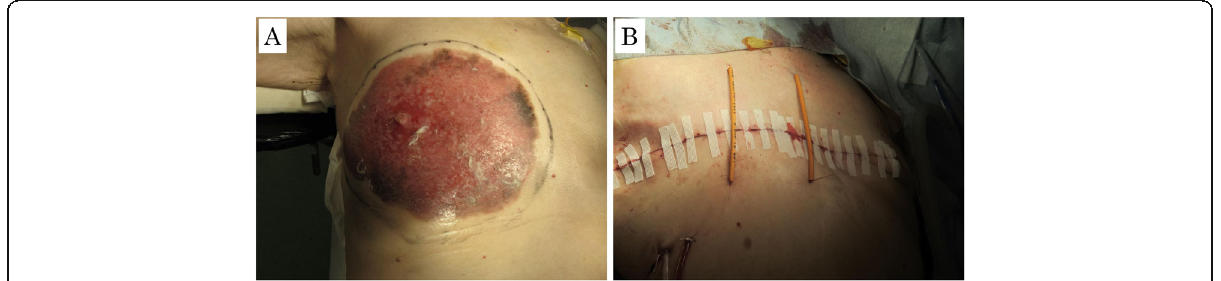
Fig. 3 Surgical findings. a Muscle-sparing mastectomy with a 1-cm margin from the edge of the skin erythema. b Two stress-relaxation sutures to avoid